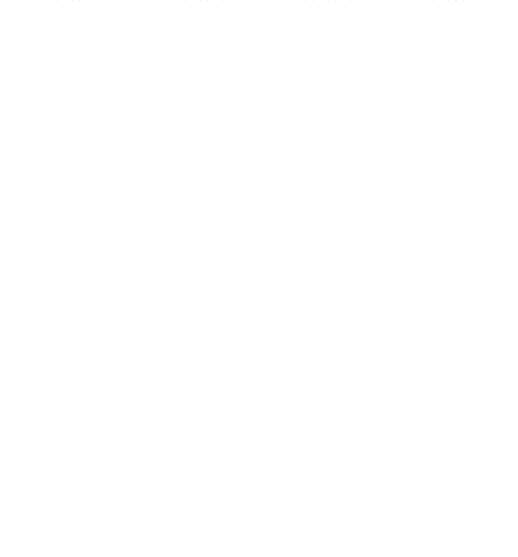
Figure 5. Phylogenetic analysis of core genome ( A ) and pan-genome ( B ) of N. fowleri species by BPGA pipeline.